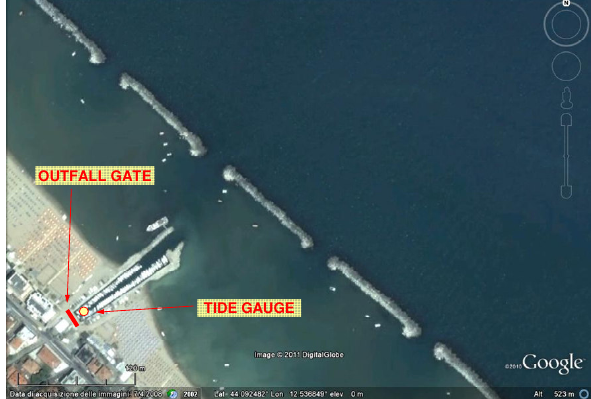
Fig. 5. Drainage network outfall and tide gauge location.